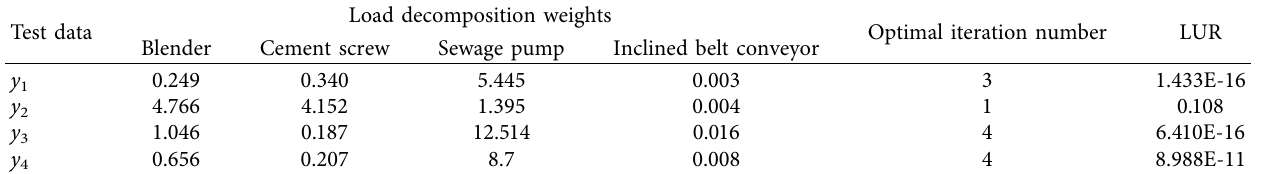
Table 8: Load decomposition results for the steady-state process.